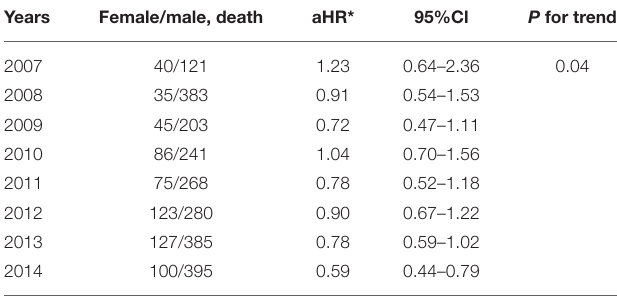
TABLE 5 | Trend in 5-year mortality